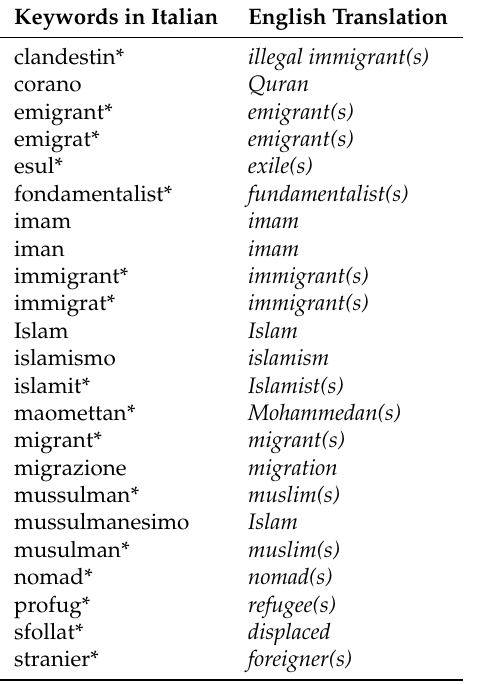
Table 1. List of keywords in Italian (and their English translation) used to compile the dataset. Keywords in Italian English Translation clandestin* illegal immigrant(s)